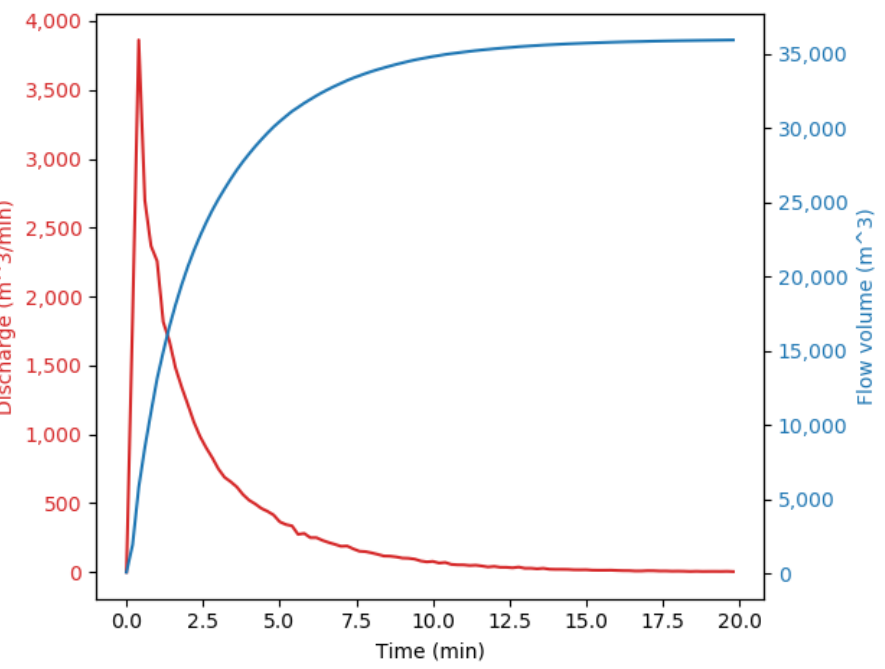
Figure 11. Discharge (red) and the volume of liquid poured out of the lake (blue) versus time from the start of the